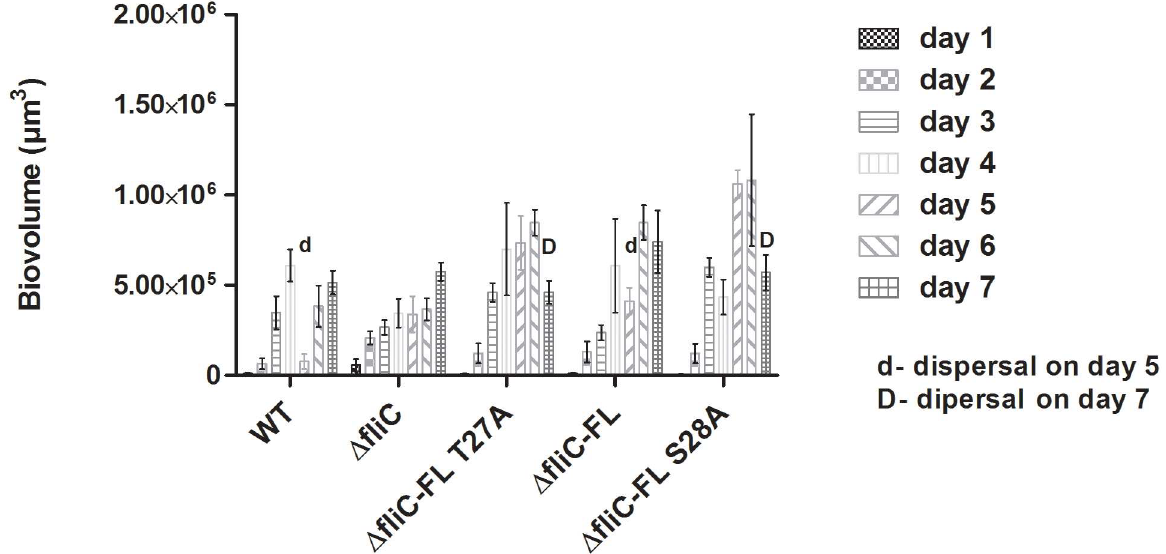
Fig 7. FliC phosphomutants have delayed dispersal. Total biovolumes of PAO1 WT, Δ fliC , Δ fliC -FL T27A, Δ fliC -FL and Δ fliC -FL S28A strains measured over a 7 day flow cell experiment. Reduction in biovolumefrom day 4 to day 5 in WT and Δ fliC - FL and from day 6 to day 7 in Δ fliC - FL T27A and Δ fliC - FL S28A is observed.Error bars represent mean ± SD for three